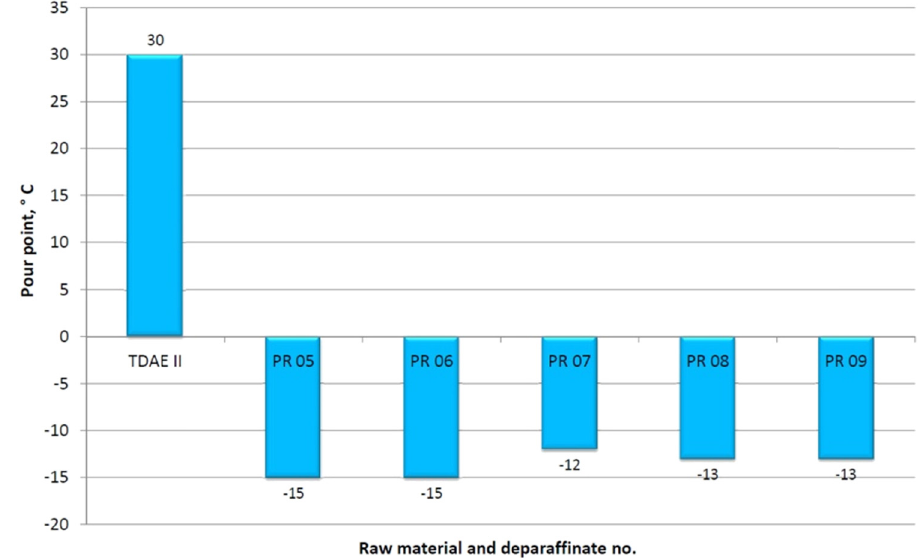
Figure 5: E ff ect of the dewaxing process with the MBIK – MEK solvent on the change of the depara ffi nate pour point – TDAE II raw